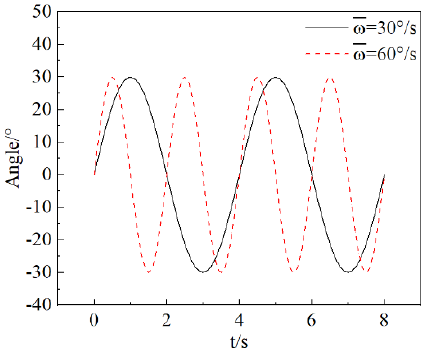
Figure 12. Flow characteristics of inlet under typical sideslip angles.